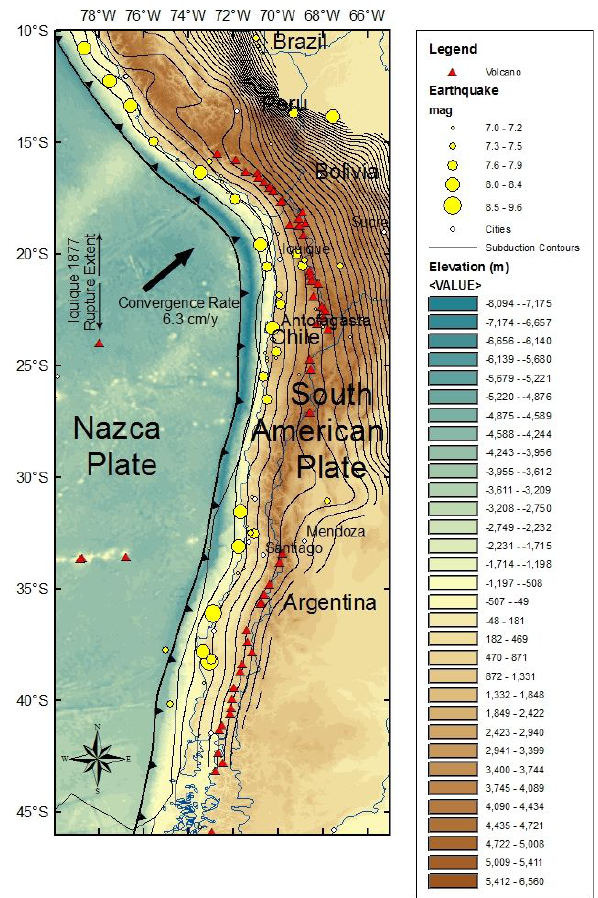
Figure 1: Regional map of the Peru Chile subduction zone. The ele- vation data are from the National Oceanic and Atmospheric Admin- istration. Black arrow indicates the direction of plate motion. Red triangles are for volcanos. The yellow circles indicate earthquake epicenters (events from 1957 - 2018; USGS Earthquake